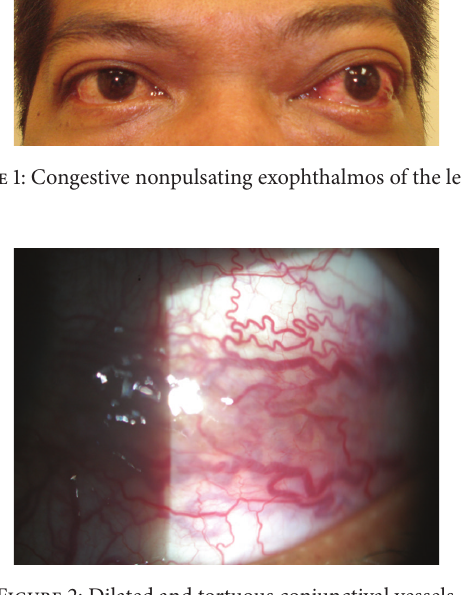
Figure 2: Dilated and tortuous conjunctival vessels.